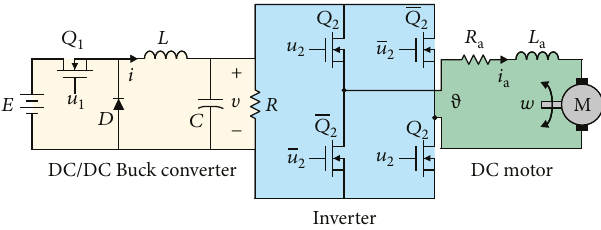
Figure 1: DC/DC Buck converter-inverter-DC motor